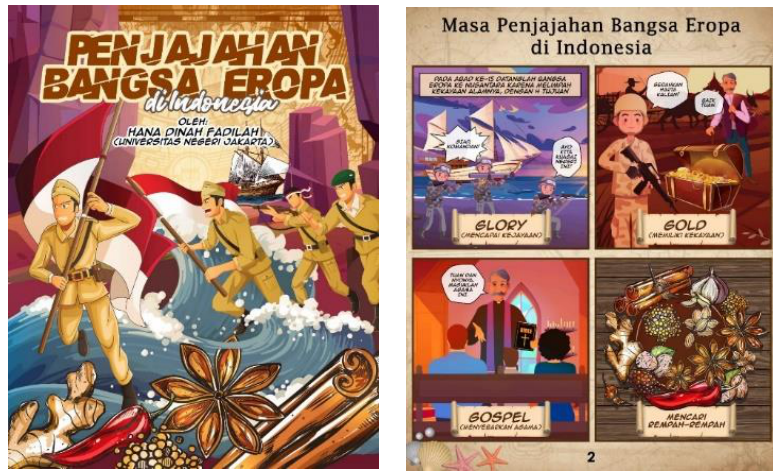
Figure 4. Cover and story display in